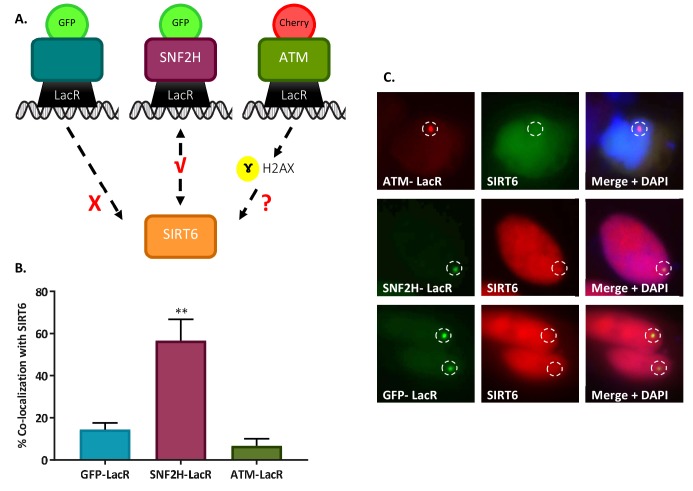
SIRT6 is not recruited by signaling.(A) Schematic representation of the ‘Tethering assay’. Recruitment can occur through DDR signaling (ATM-LacR-Cherry) or through direct protein–protein interaction (SNF2H-LacR-GFP). (B, C) Recruitment of SIRT6-GFP/SIRT6-Cherry to LacO sites by ATM-LacR-Cherry (n = 30, p>0.05), SNF2H-LacR-GFP (n = 85, p<0.005) and GFP-LacR (n = 85). The bar chart in panel (B) depicts averages for3–6 experiments. Error bars are SEM.